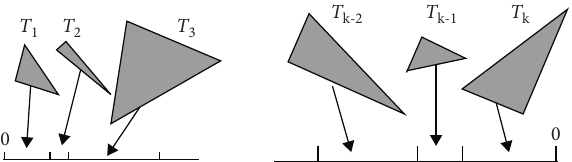
Figure 1: Schematic diagram of triangular patches selected randomly.